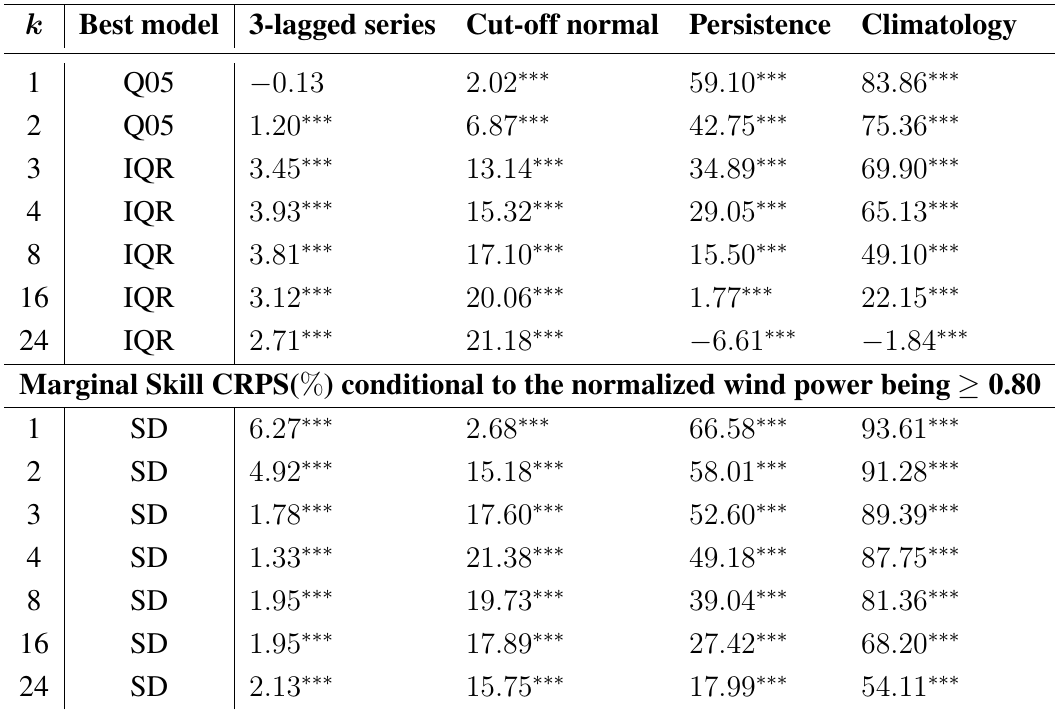
Table 14. The best performing model (according to the Marginal Skill CRPS) among the four competing ones, and its performance gain/loss with respect to the four reference (benchmark) models, for forecast horizon k (measured in 15 min steps). Reference models: 3-lagged series (column 3), Cut-off normal (column 4), Persistence (column 5) and Climatology (column 6). These results are outcomes from an averaged over 24-steps CFS